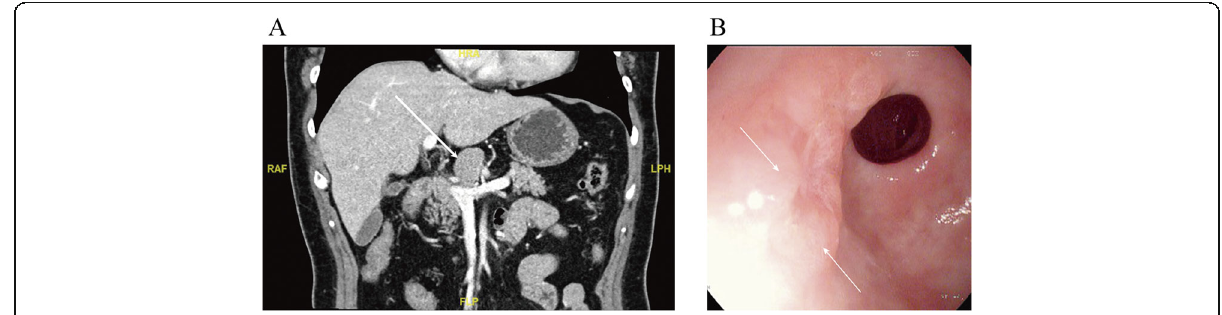
Fig. 2 The last preoperative tests. a The latest contrast-enhanced abdominal CT. Stable solitary nodule (32mm × 25mm), labeled by the white arrow, without other abnormal findings. b The retaken gastroscopy found two bumps with mucosa erosion near the pylorus on the anterior gastric antrum, and a biopsy was taken around this